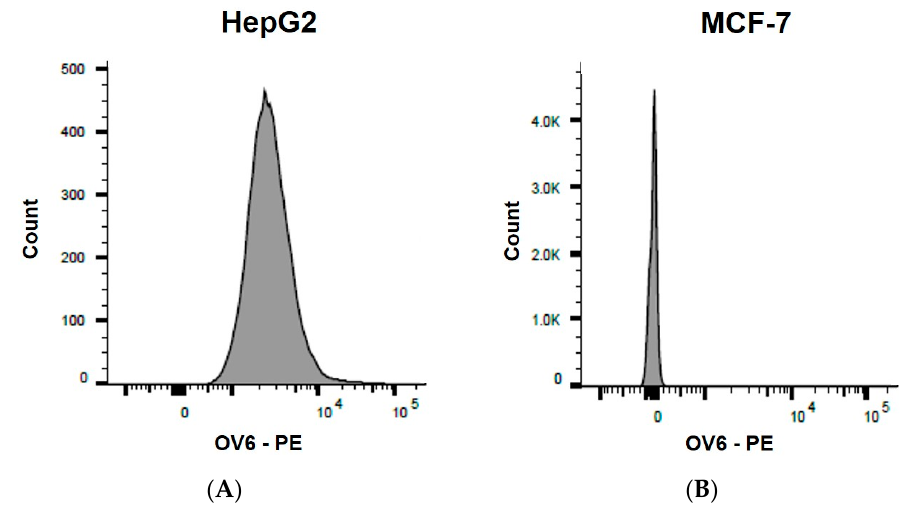
Figure 3. Flow cytometry detection of OV6 in HepG2 and MCF-7 cell lines. The figure shows OV6 + (positive) on HepG2 ( A ) and OV6- (negative) on MCF-7 ( B ).